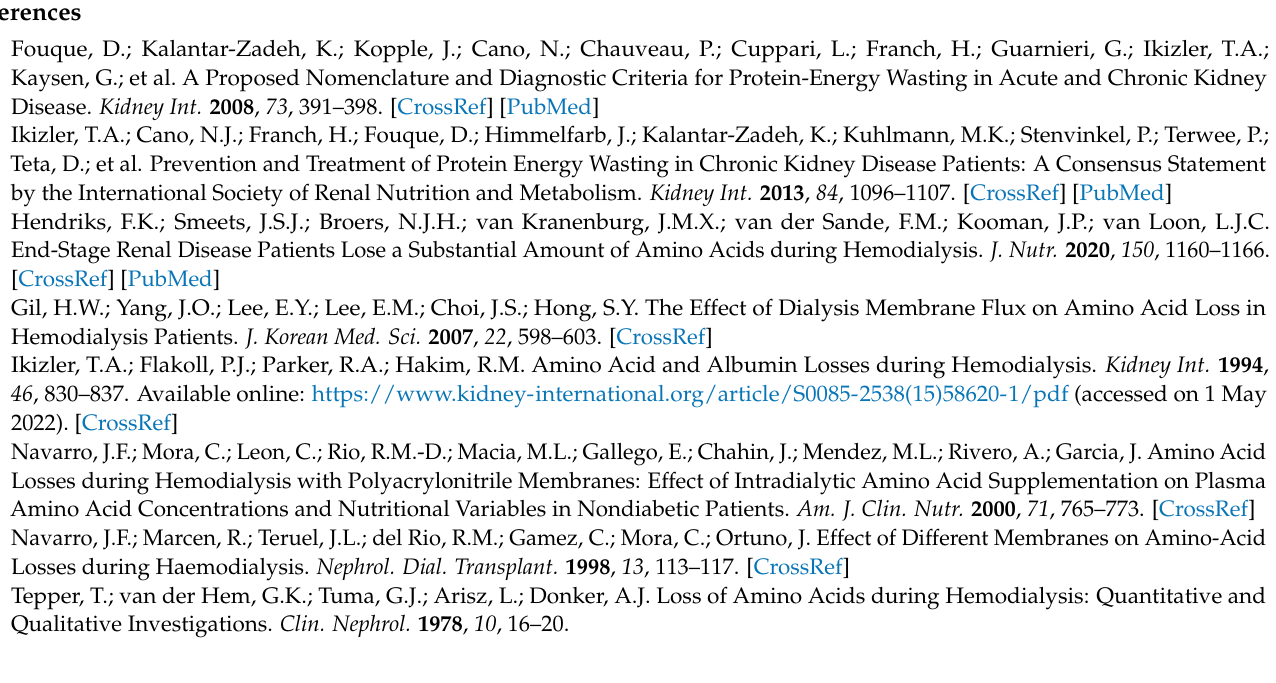
analyses on the determinants of the daily amino acid losses in hemodialysis patients. Table S3. Single dialysis losses, dialytic clearance, and fractional clearances of amino acids in hemodialysis patients. Table S4. Daily dialysis losses and urinary losses of amino acids in hemodialysis patients with residual diuresis. Figure S1. Graphical representation of the association of protein intake (A) and protein intake indexed to bodyweight (B) with the probability of severe fatigue. The analyses are adjusted for age, sex, body mass index, dialysis vintage, hemoglobin concentration, C-reactive protein concentration, presence of cardiovascular disease, and presence of diabetes. Table S5. Sensitivity analyses of the logistic regression analyses with severe